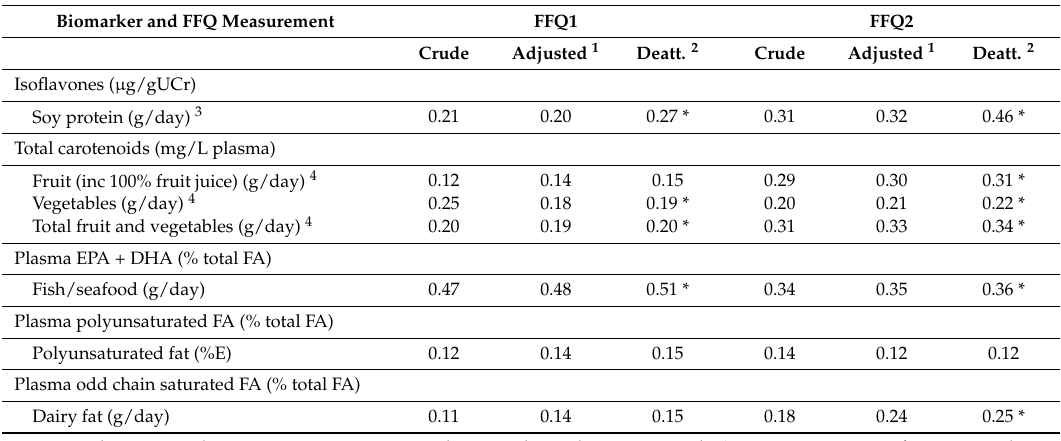
Table 4. Pearson correlations between FFQ1 and FFQ2, and biomarkers, n =